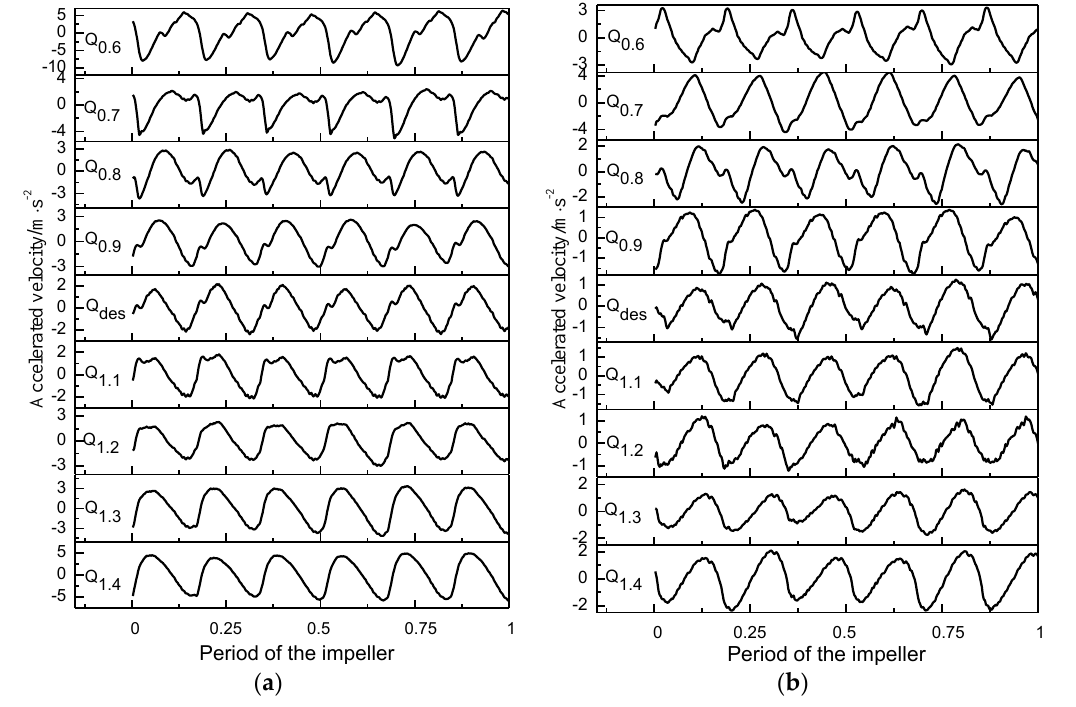
Figure 21. Time-varying acceleration under different flow conditions: ( a ) X direction; ( b ) Y direction.